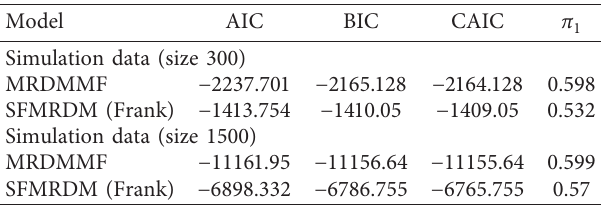
Table 3: Selection criteria values of the second scenario of the simulation study.